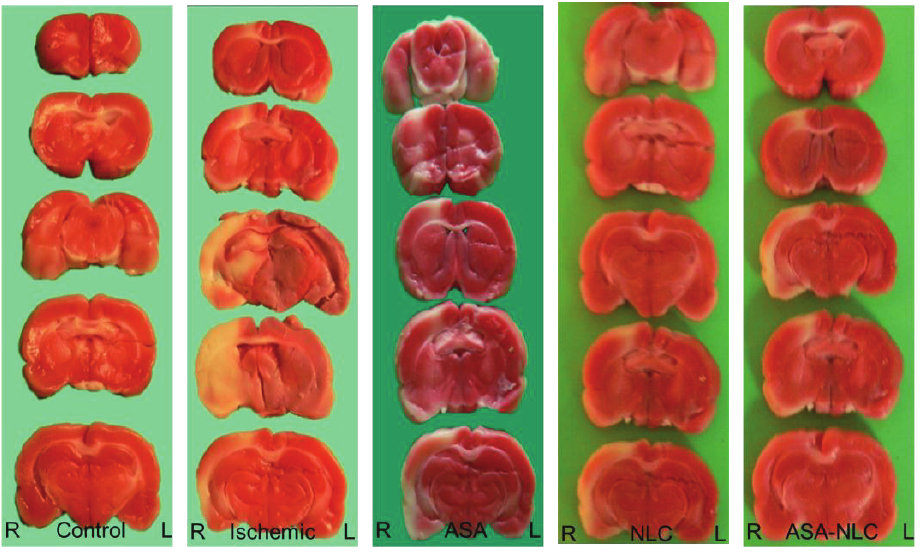
Fig. 5. Figure 5: TTC staining displayed ischemic area (pale area) in all groups except the control group. Administration of ASA and neural-like